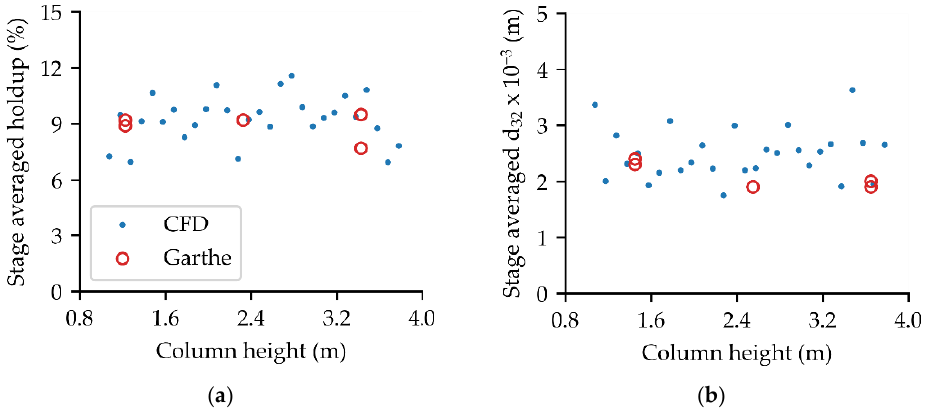
Figure 7. Stage-averaged results along the PSEC compared to experimental values [25] for: ( a ) dis- persed phase holdup; ( b ) Sauter mean droplet diameter.